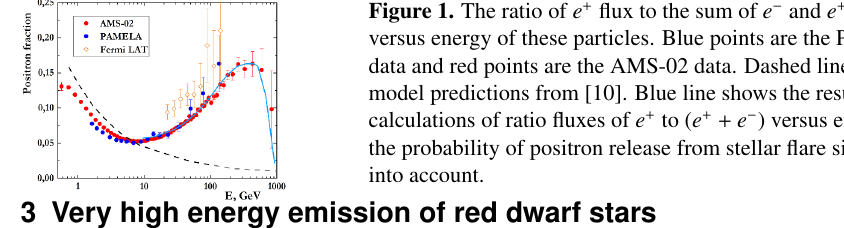
Figure 1. The ratio of e + flux to the sum of e − and e + fluxes versus energy of these particles. Blue points are the PAMELA data and red points are the AMS-02 data. Dashed line shows model predictions from [10]. Blue line shows the result of calculations of ratio fluxes of e + to ( e + + e − ) versus energy if the probability of positron release from stellar flare site is taken into account.